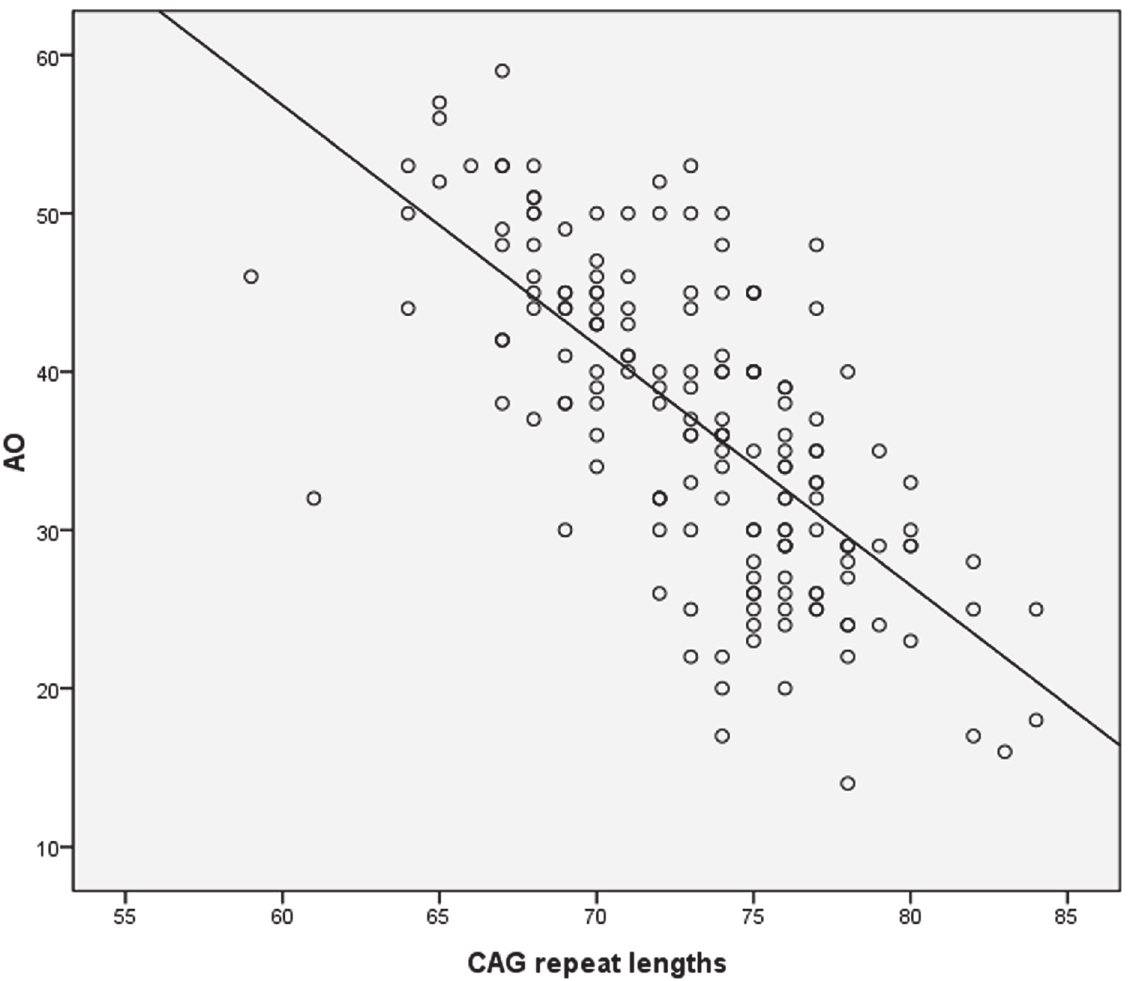
Fig 1. The association of expanded CAG repeats in the expanded ATXN3 gene with age at onset (AO) in SCA3/MJD patients. The X-axis indicates the expanded CAG repeat lengths and the Y-axis denotes AO in years. AO of SCA3/MJD is inversely correlated with the length of CAG repeat ( r = − 0.694, p =